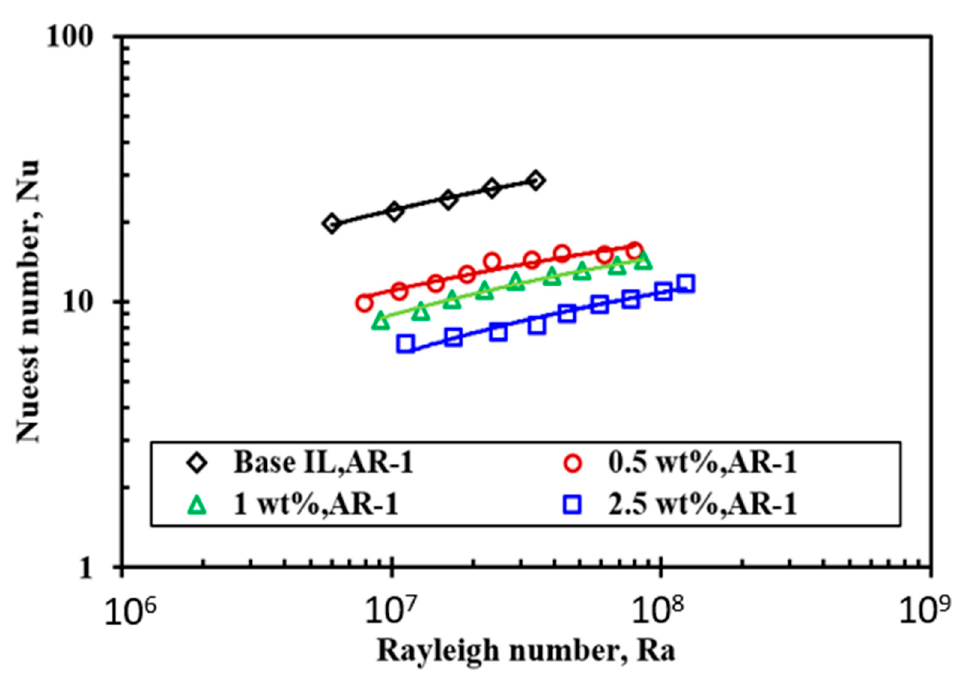
Figure 21. Natural convection heat transfer behavior of [C 4 mpyrr][NTF 2 ]IL and ILs-based nanoflu- ids [84]. Reproduced with permission from [Paul], [Int. J. Heat Mass Transf.]; published by [Else- vier], 2015.